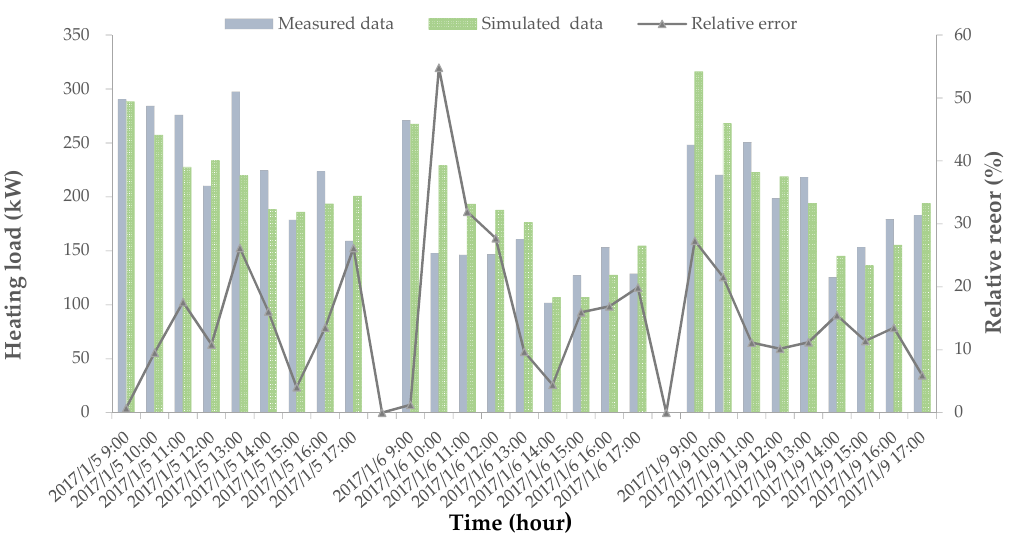
Figure 5. Comparison between the simulated heating load and the measured heating supply.